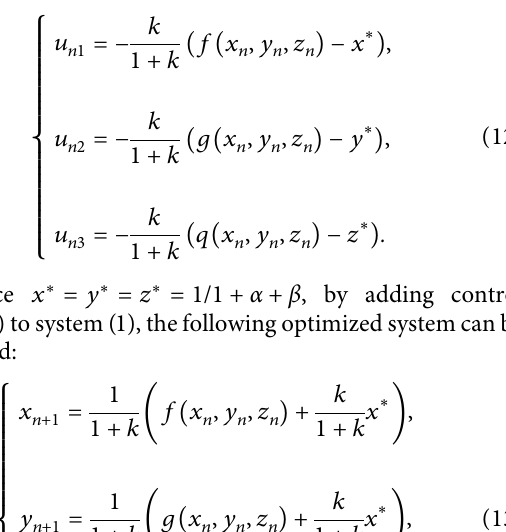
Figure 5: (a) Spatial Julia set J ( F ) with R � 1 , α � 0 . 4745 , and β � 3; (b) 2D-filled slice K ( F ) with z x � 0 . 01; (d) local zoom of c , where we choose point A � ( 0 . 22 , 0 . 19 ) ∈ K ( F ) and point B � ( 0 . 23 , 0 . 195 ) ∉ K ( F ) 0